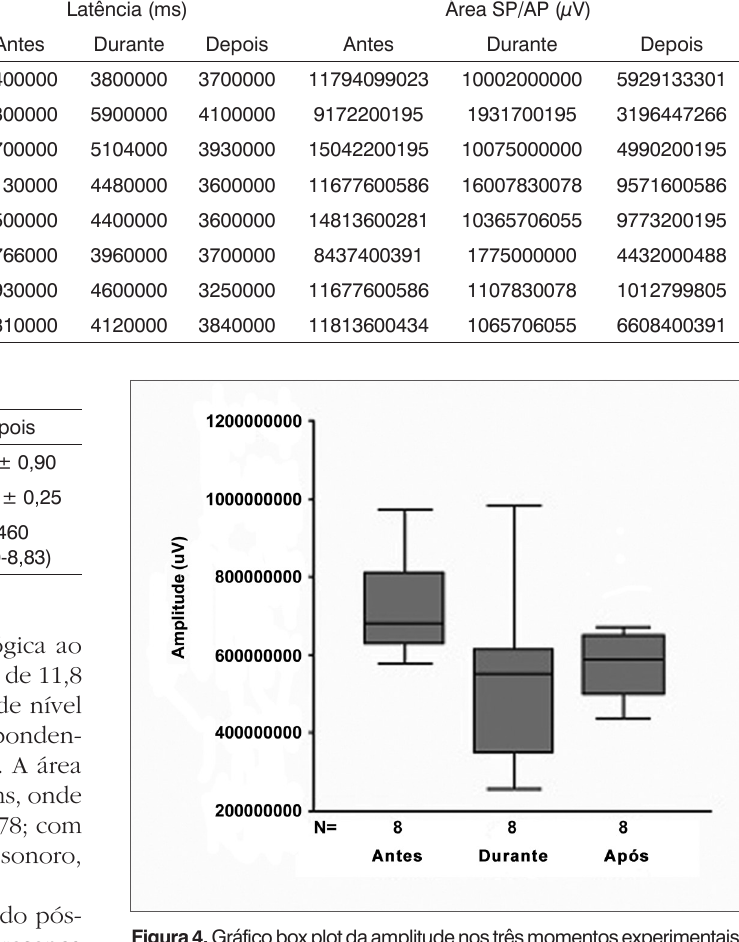
pelo menos 30 dias após o procedimento